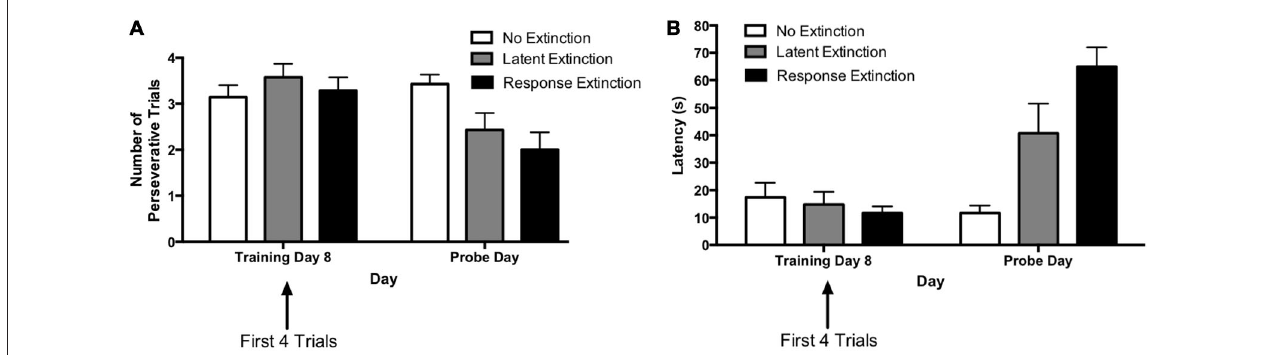
FIGURE 3 | Extinction probe trials in the hippocampus-dependent place learning task. (A) There were no between-group differences in perseveration during the first few trials of the last training day (i.e., training day 8). Response and latent extinction groups, but not the “no extinction” group, displayed a decrease in number of perseverative trials from the last acquisition day to the probe day. On the probe day, the latent and response extinction groups displayed lower perseveration than the no extinction group, but the latent and response extinction groups did not differ from each other in perseveration. (B) There were no differences in latency between groups on the last training day. Response and latent extinction groups, but not the “no extinction” group, increased latency from the last acquisition day to the probe day. On the probe day, the latent and response extinction groups had higher latency than the no extinction group. Latency was also higher in the latent extinction group vs. the response extinction group on the probe day. Results indicate the effectiveness of latent and response extinction protocols in extinction of hippocampus-dependent place learning.